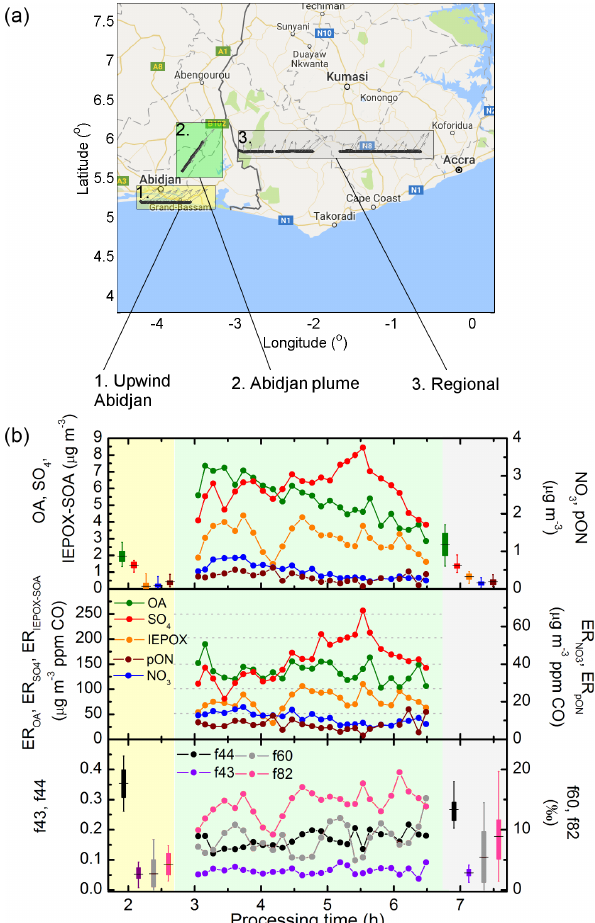
Figure 5. Map (a) and plume analysis (b) for upwind of Abidjan (rectangle 1, yellow), within the plume (rectangle 2, green) and sampling regional aerosol (rectangle 3, white). Processing time is calculated based on integrated wind speed and distance from Abid- jan. Aircraft measurements were carried out first sampling Abidjan plume around 09:30, upwind of Abidjan around 10:00, and regional aerosol at 13:30UTC (identical to local